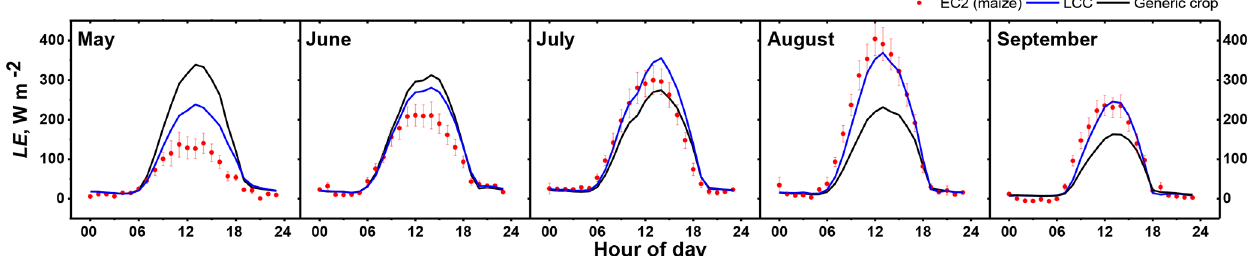
Figure 5. Monthly averaged measured and simulated diurnal latent heat flux ( LE ) for May–September. The Noah-MP LSM was run with two different vegetation parametrizations: late-covering crops (LCC) and generic